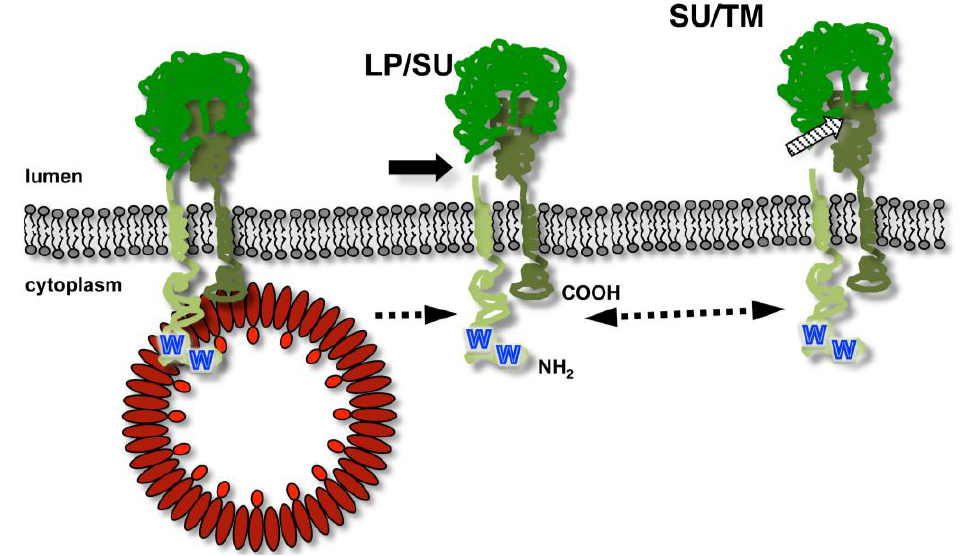
Figure 4. The specific foamy virus capsid – glycoprotein interaction essential for viral budding. Schematic illustration of FV precursor processing after insertion into the secretory pathway and interaction with the viral capsid (in red) essential for budding of virions. The order of LP/SU (solid arrow) and SU/TM (striped arrow) processing resulting in the different Env subunits (indicated in different shades of green) has not been defined. N-terminus (NH2) and C-terminus (COOH) are indicated. The essential WxxW motif in the LP CyD is indicated by blue W